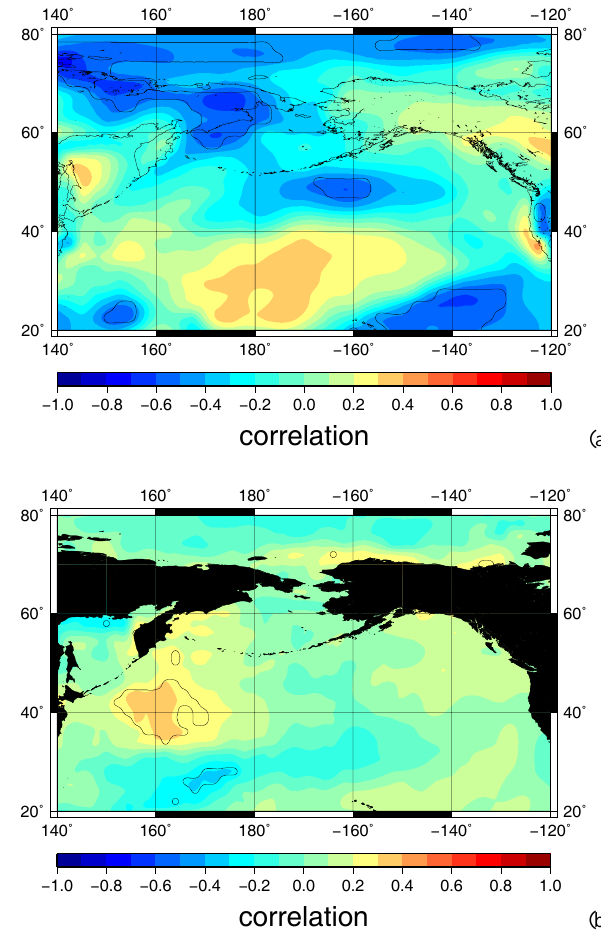
Fig. 10. (a) Correlation map of reconstructed accumulation rates (Elmer/Ice) with ERA-40 3yr mean surface (2m) temperature for 1958–1996 (39yr). Black contours indicate the land-water margin and the 90% confidence level. (b) Correlation map of reconstructed accumulation rates (Elmer/Ice) with ERSST 3yr mean sea surface temperature for 1854–1995 (142yr). Black contours indicate the land-water margin and the 90% confidence